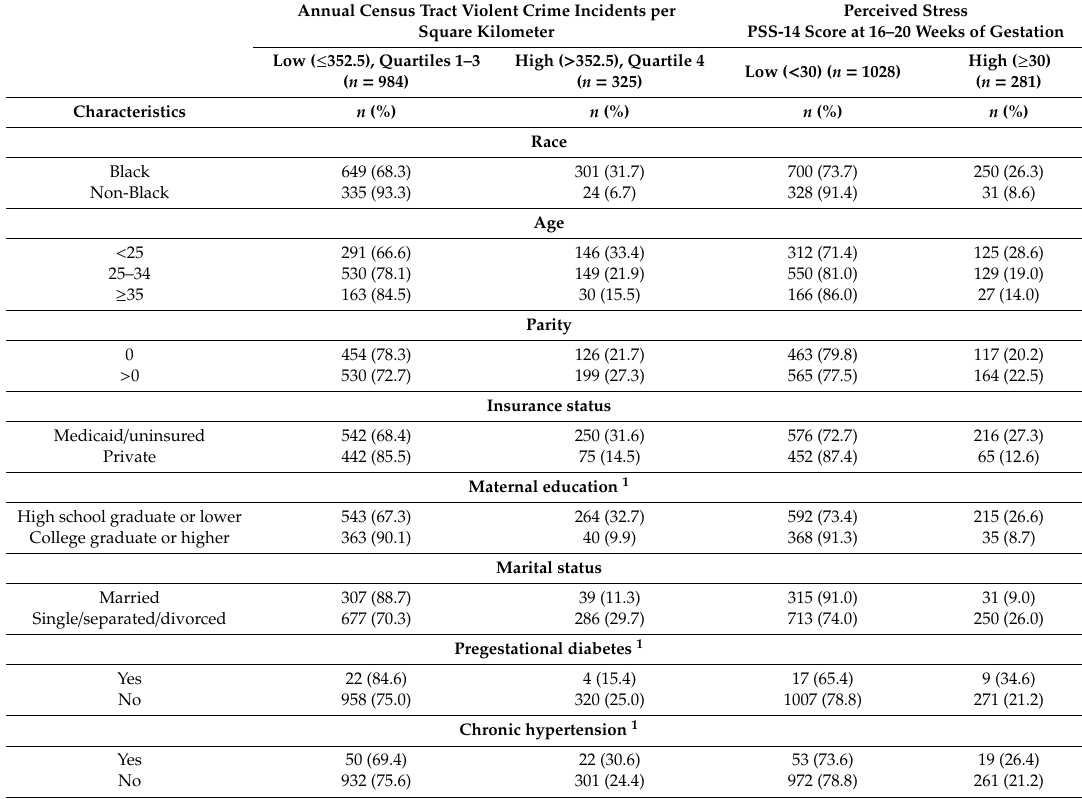
Table 1. Neighborhood violent crime and perceived stress among 1309 pregnant women in Philadelphia participating in the Motherhood and Microbiome , by sociodemographic and health characteristics.